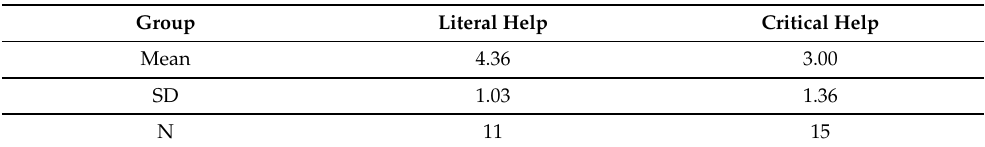
Table 3. Independent Samples T-Test run in order to evaluate the risk/acceptability of the critical help compared to the critical help ( RQ1 ). The p -value associated to the T-Test is p = 0.010; the Cohen’s d is d = 1.11 that represents a large effect size.